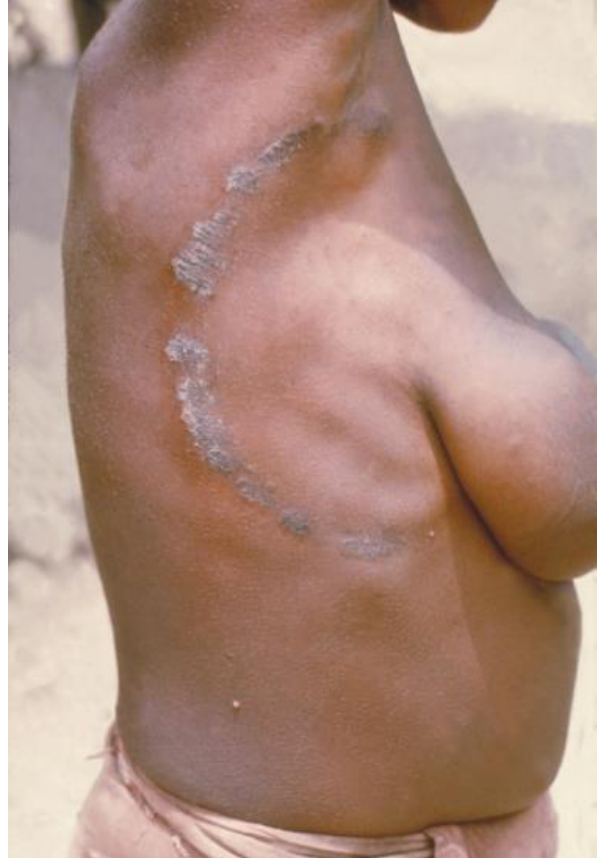
Figure 2. Ringworm on a woman’s skin caused by Trichophyton rubrum , a fungus that lives in soil. (Courtesy of the Centers for Dis- ease Control and Prevention, image